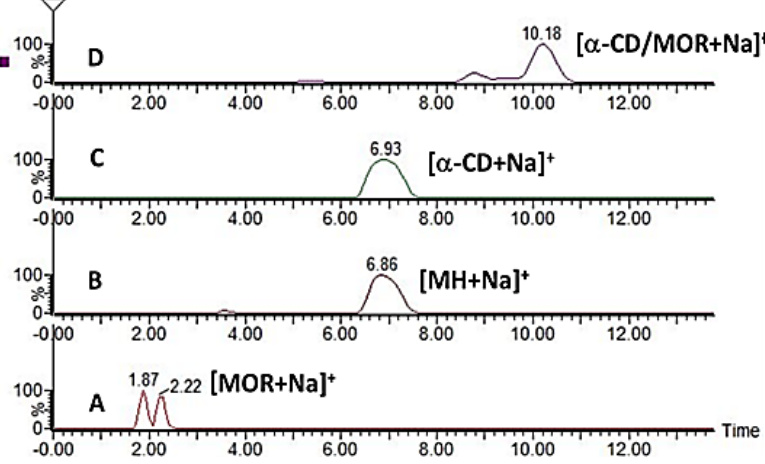
Figure 7. Comparison of reconstructed mobility traces of sodium adduct ions of MOR ( A ), MH ( B ), α-CD ( C ) and an equimolar mixture of α-CD/MOR ( D ) with following ion mobility separation (IMS) parameters: wave velocity (WV) = 600 m/s, wave height (WH) = 40 V.